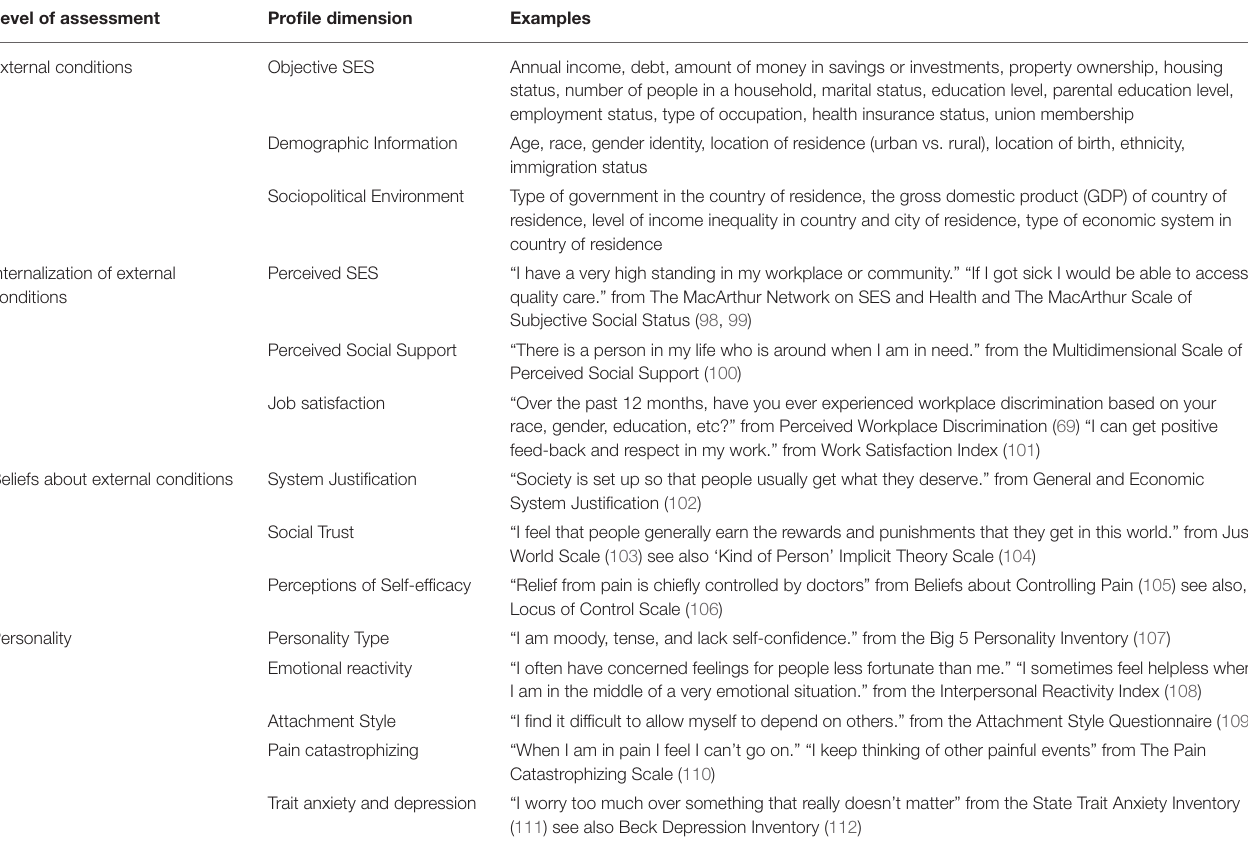
TABLE 1 | Socioeconomic Pain-Predispositions Profile